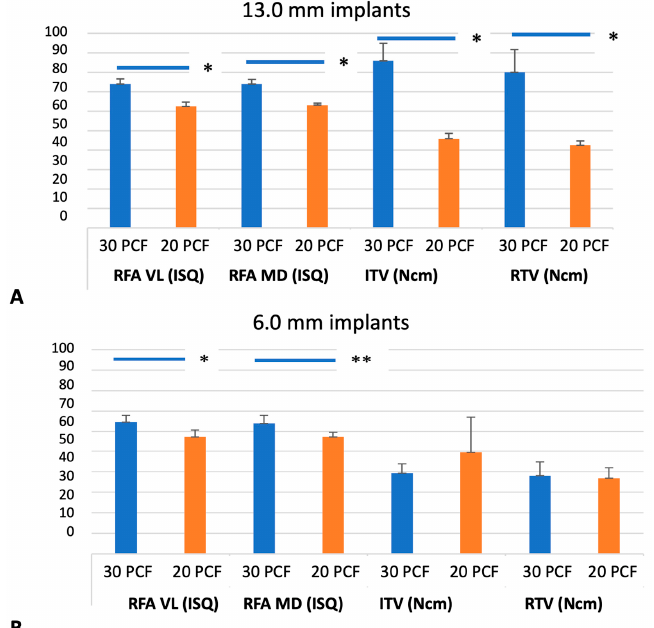
Figure 3. Measurements of primary stability of long implants ( A ) and shorts ( B ) implants on polyurethane blocks of 20 and 30 PCF. * p -value < 0.01; ** p -value < 0.05. RFA-VL = vestibulo-lingual resonance frequency analysis (ISQ); RFA-MD = mesio-distal resonance frequency analysis (ISQ); ITV = insertion torque value (Ncm); RTV = removal torque value (Ncm).